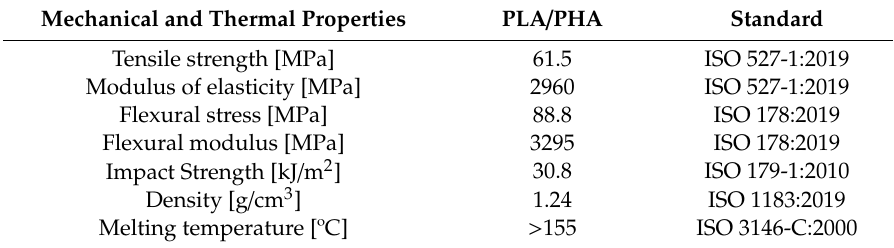
Table 3. Mechanical and thermal properties of the material used in 3D printing.